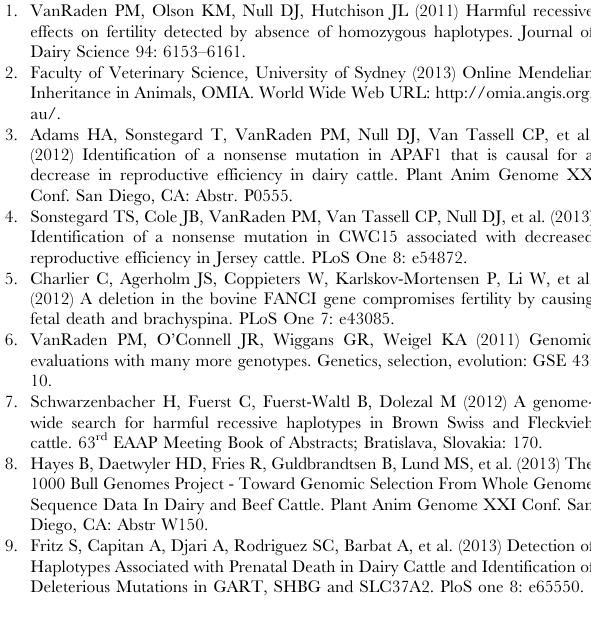
Table S2 Original and refined BH1 derived from BovineSNP50 haplotypes. Table S3 Original and refined HH2 derived from BovineSNP50 haplotypes. (XLSX) Table S4 Original and refined HH3 derived from BovineSNP50 haplotypes. Table S5 Count of total SV annotations by chromosome after filtering exome sequence from 21 animals. Table S6 SV re-genotyping results for 5 individuals with discordance between their chr8:95,410,507T . C geno- type and HH3 status. Table S7 CNVs located in BH1 locus region.